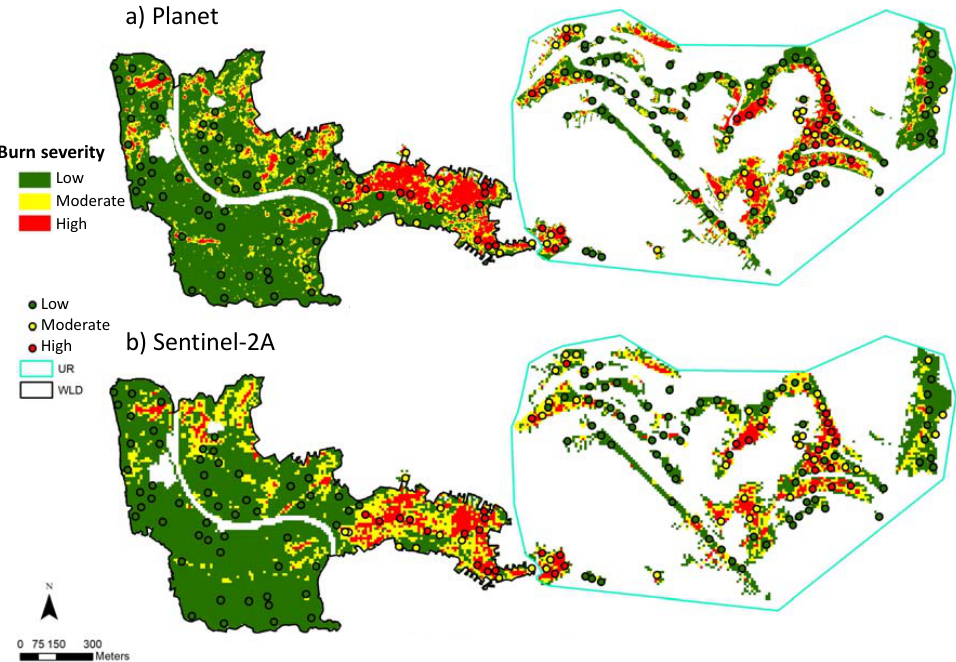
Figure 7. Burn severity maps derived from ∆ NDVI using ( a ) 3 m Planet and ( b ) 10 m Sentinel-2A Figure 7 . Burn severity maps derived from Δ NDVI using ( a ) 3 m Planet and ( b ) 10 m Sentinel ‐ 2A images. The plot-based classification of the burn severity levels is also shown images. The plot ‐ based classification of the burn severity levels is also shown (circles).